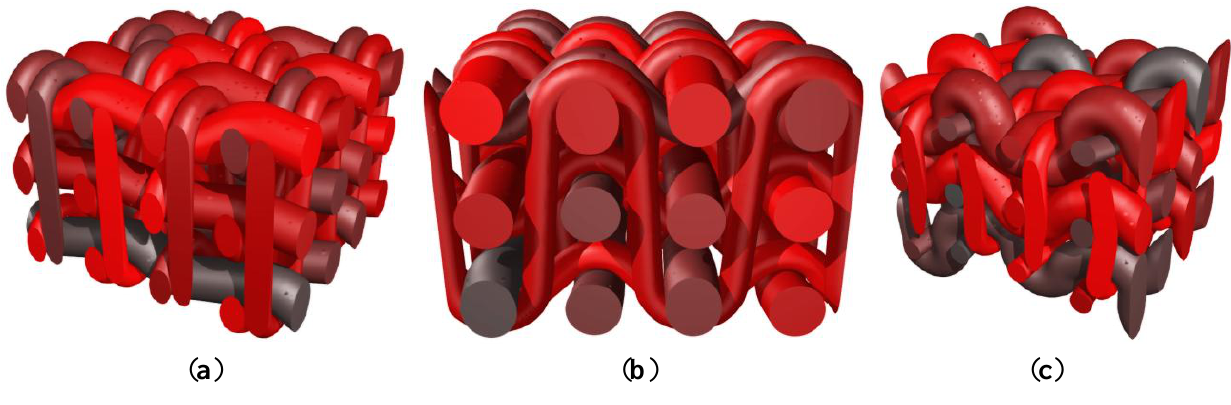
Figure 10. Reinforcement scheme with warp yarns and binders alternating on three plies of weft yarns. ( a ) Normally tensioned weft yarns ( p tensioned weft yarns—side view; and ( c ) effect of excessive tension in binders ( p